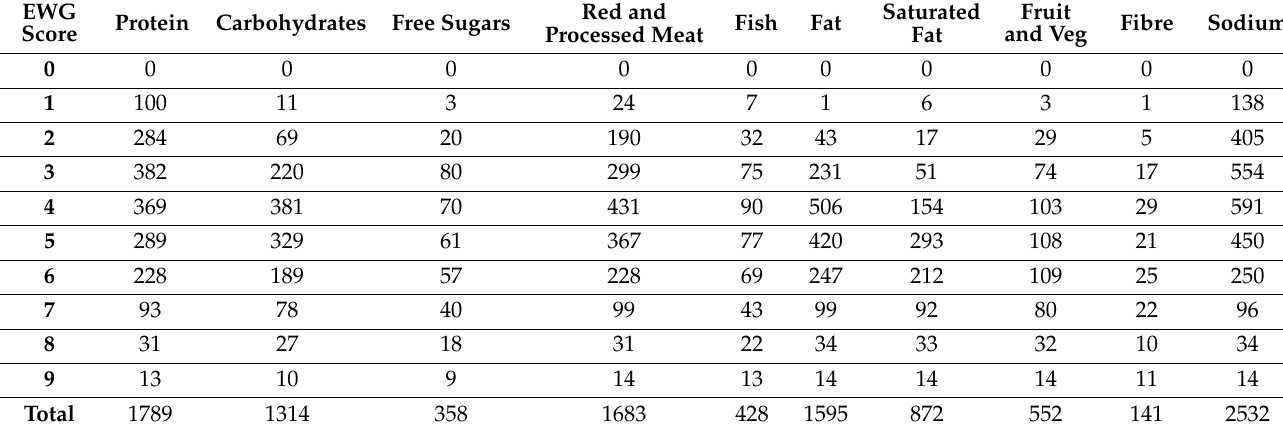
Table 2. Number of individuals meeting each of the 10 recommendations underpinning the